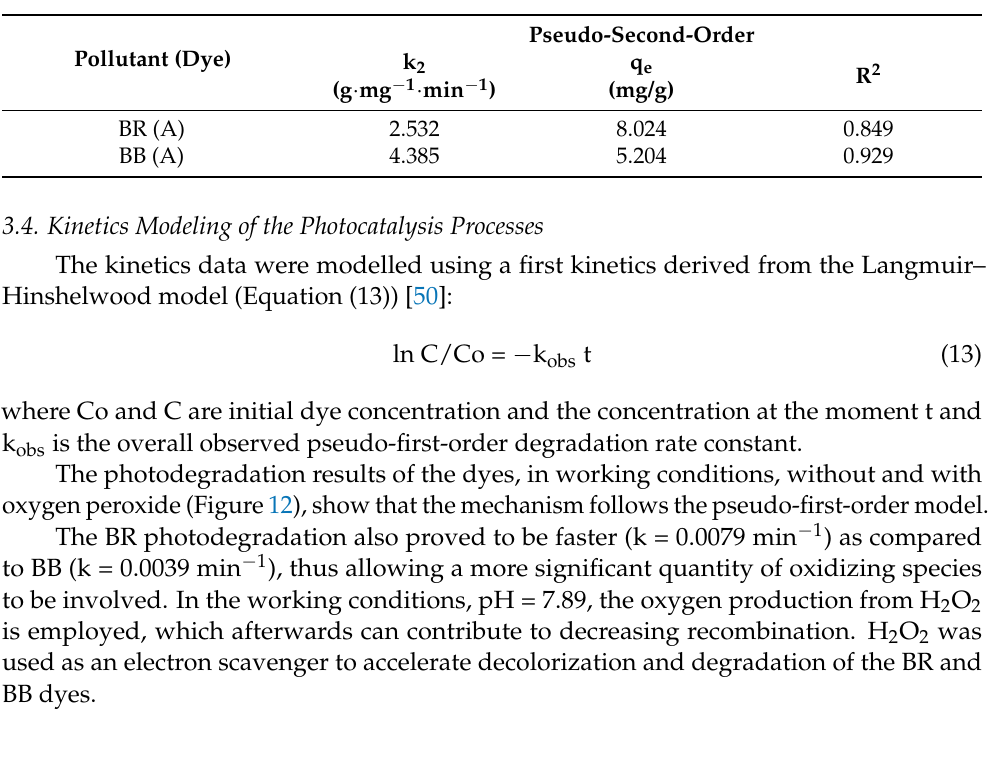
Table 8. Kinetic parameters of the dye removal in adsorption